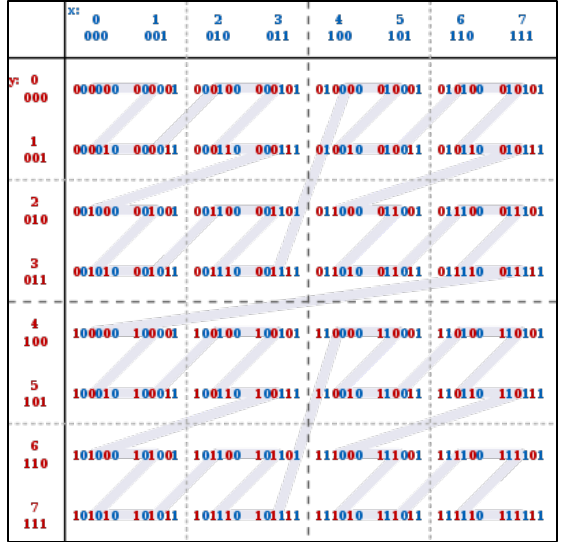
Figure 3. Morton Encoding